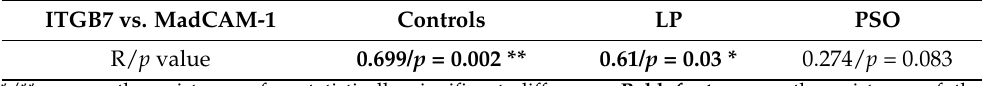
Table 6. Correlations between both proteins in studied groups.